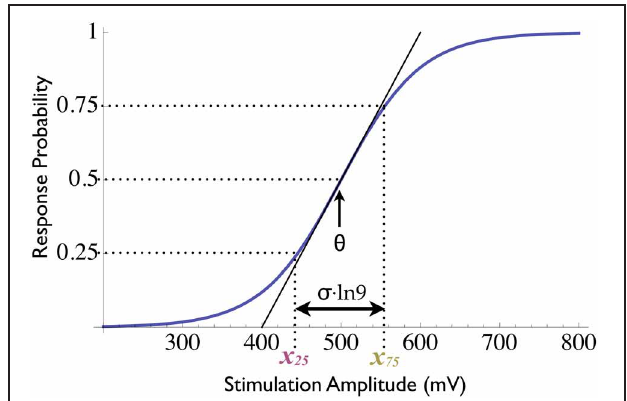
FIGURE 1 | Sigmoidal input–output relations. The response probability’s dependence on stimulation intensity follows a sigmoidal function with two parameters (state variables): the threshold θ and the dynamic range σ (see Equation 1). When two response clamps are used, one controller may clamp to 0.75 and the other to 0.25, thus yielding measurements of two distinct loci on the response curve (denoted x 75 and x 25 , respectively). The mean of these measurements is the threshold, while their difference is proportional to the dynamic